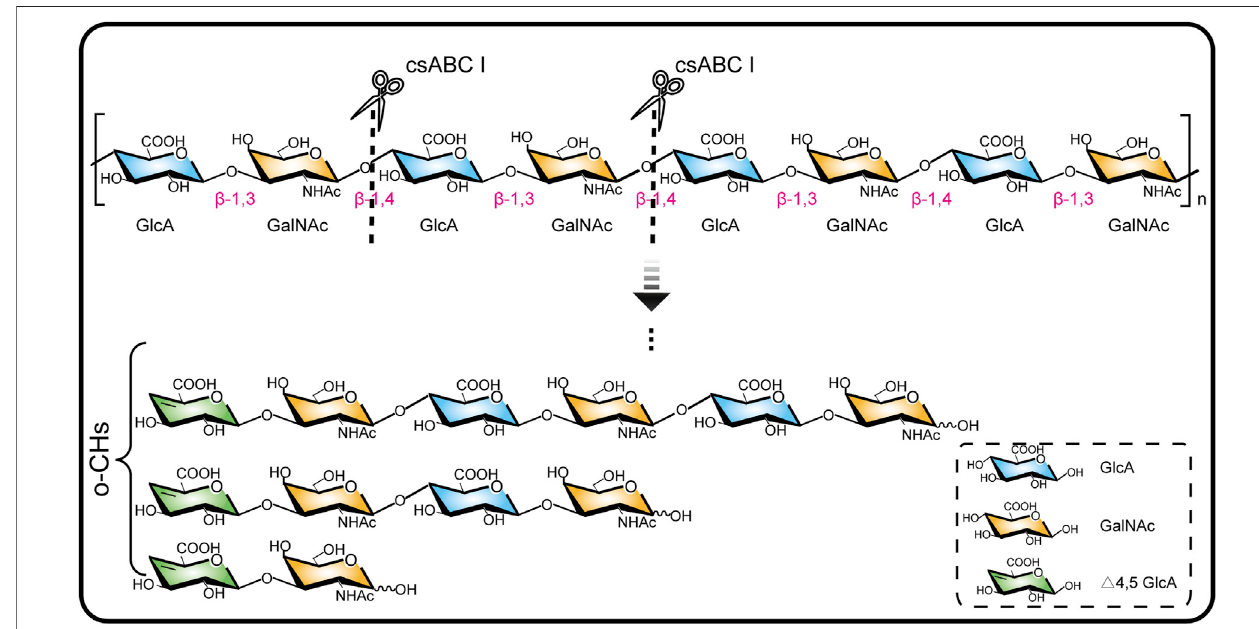
FIGURE 1 | Chondroitinase ABC I depolymerizes chondroitin chain by breaking the β -1,4 glycoside bond.